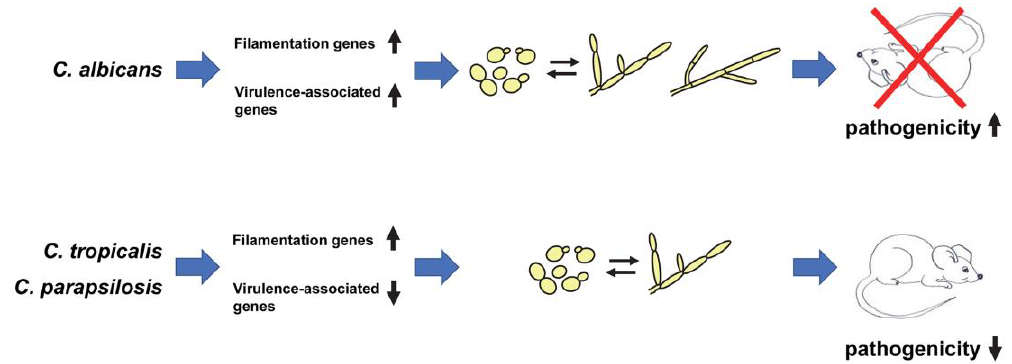
Figure 1. Model for evolutionary differences in the relationship between morphology and pathogenicity among Candida species. In C. albicans , genes important for filamentation are coordinately expressed with those involved in other virulence-related processes, leading to a strong association of the yeast–filament transition with pathogenicity. In C. tropicalis and C. parapsilosis , genes involved in filamentation are also induced but there is an accompanying down-regulation of certain genes involved in virulence-related processes, resulting in an inverse correlation between filamentation and pathogenicity. For second column, upward and downward arrows indicate increased and decreased gene expression, respectively. For fourth column, upward and downward arrows indicate increased and decreased pathogenicity, respectively. Please note that not all virulence-related genes may be down-regulated during filamentation of NACS and that alternative mechanisms not associated with changes in gene expression may account for the reduced pathogenicity of C. tropicalis and C. parapsilosis upon filamentation. Although not depicted, C. tropicalis is capable of forming hyphal filaments (adapted from [20,50]).